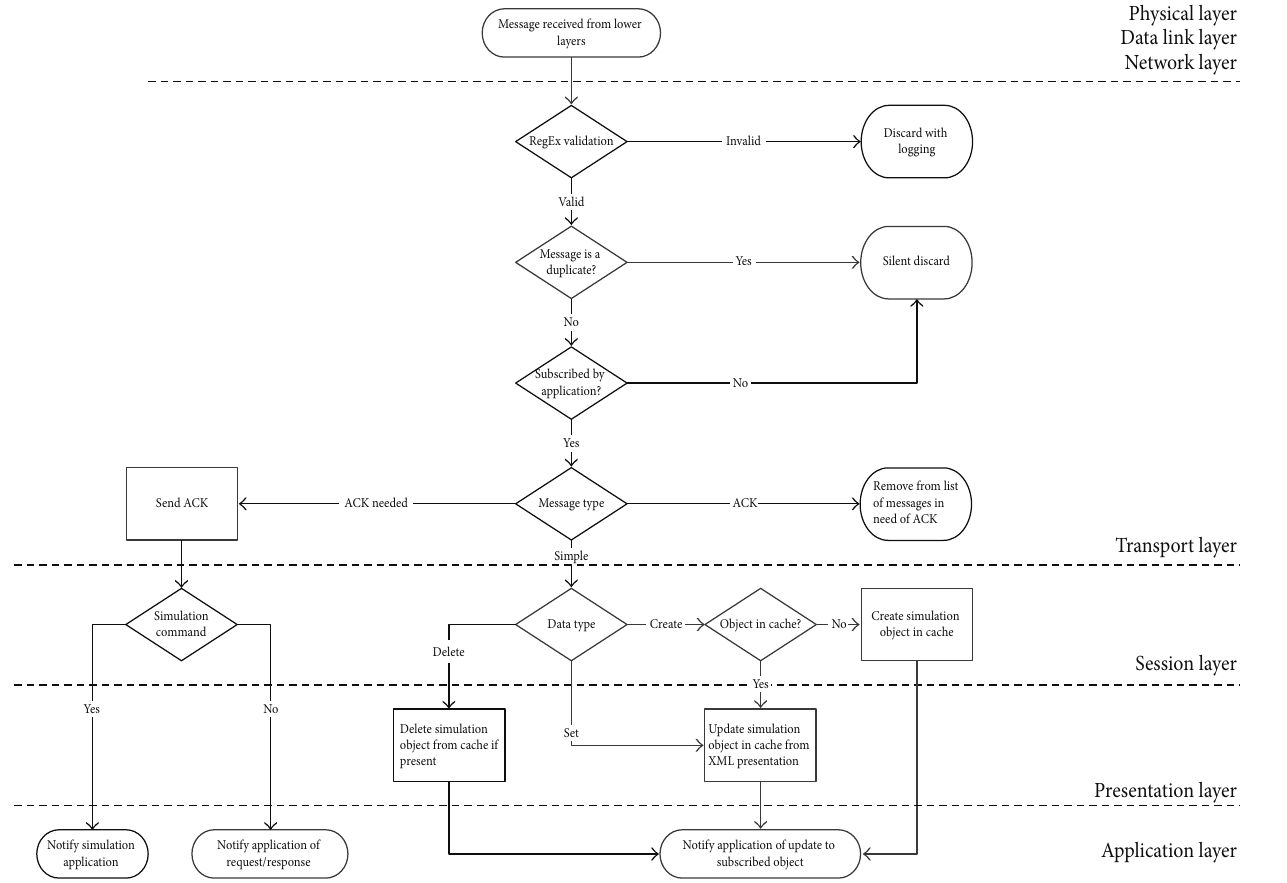
Figure 6: Processing of received messages in the X23